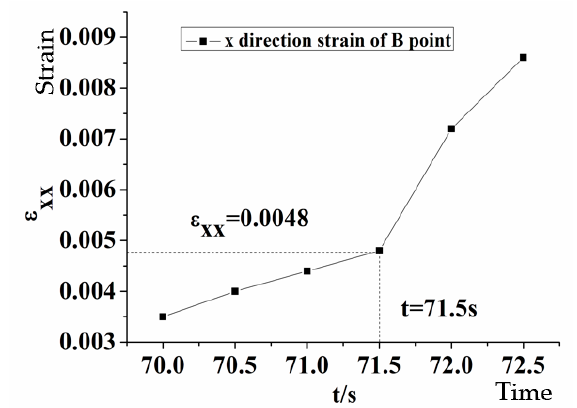
Figure 15. X-direction strain–time relationship at point B (loading rate = 0.3 MPa/s).